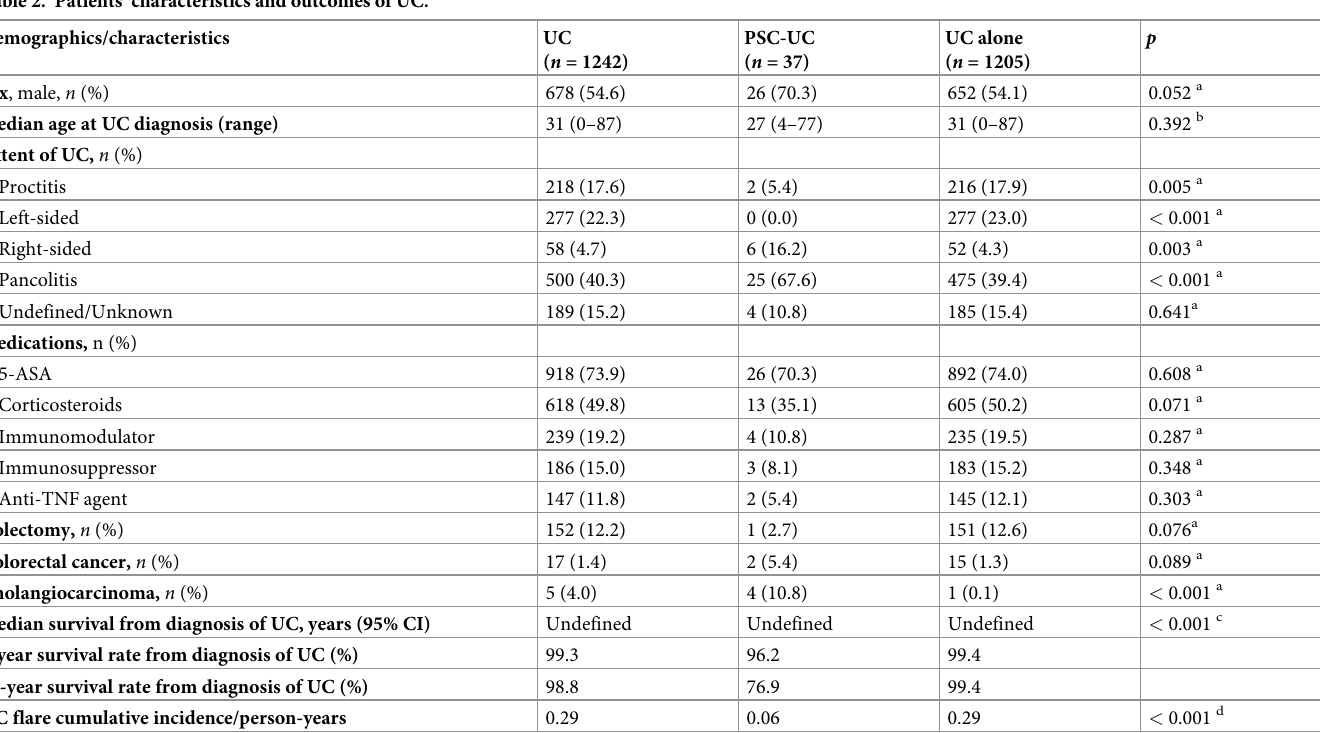
Table 2. Patients’ characteristics and outcomes of